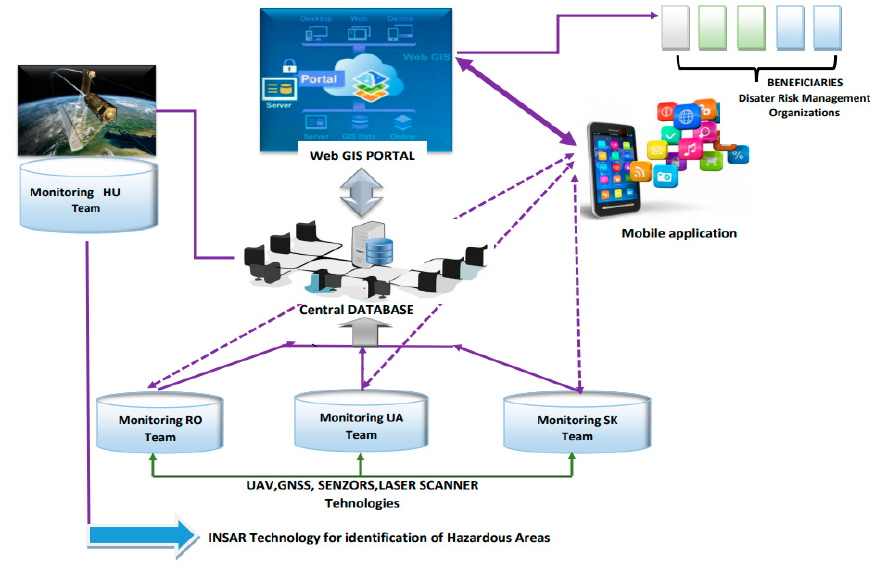
Figure 2. GeoSES Monitoring System.